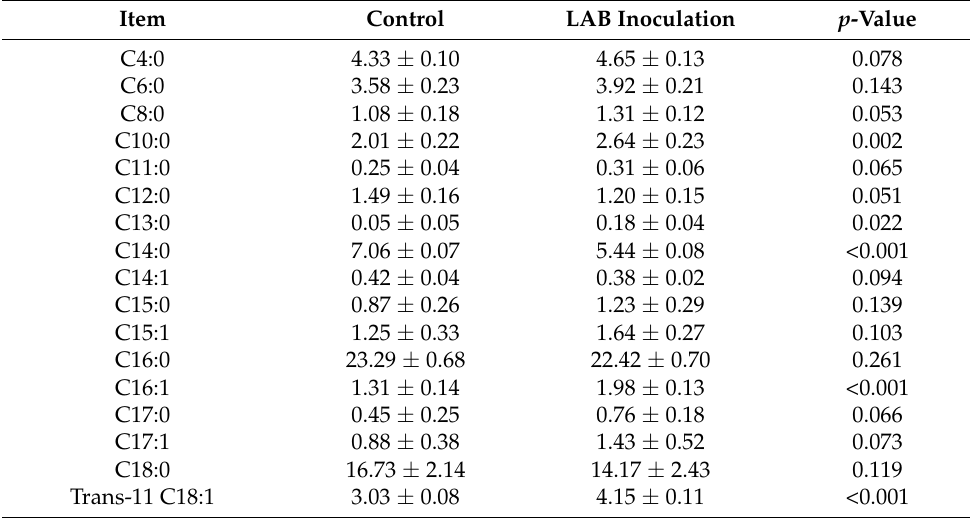
Table 5. Fatty acid composition (g/100 g fatty acid) of yak individual